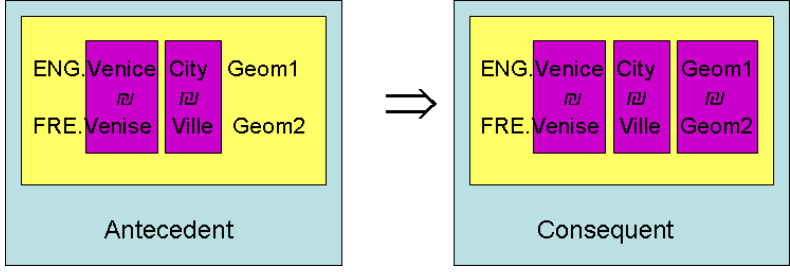
Figure 11. Example illustrating Rule